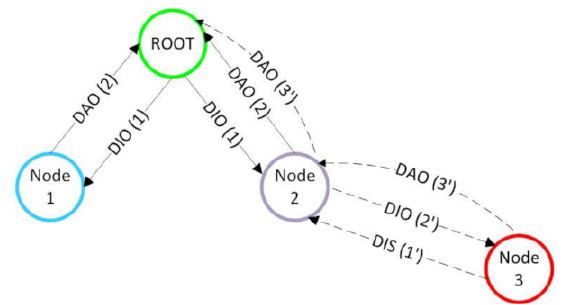
Figure 2. Message exchange during the construction of the DODAG for the different steps (denoted between brackets). DAO: destination advertisement object; DIO: DODAG Information Object; DIS: DODAG Information